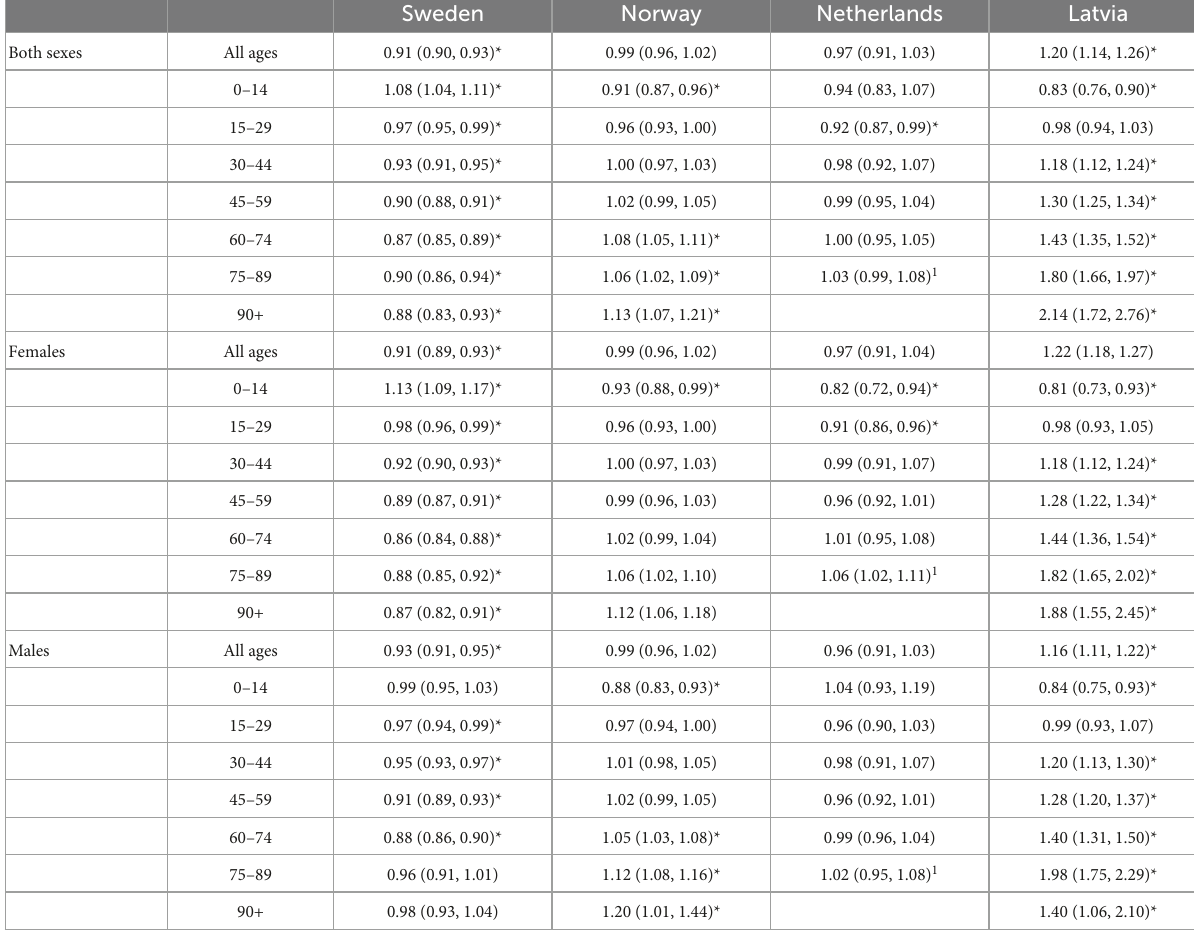
TABLE 2 Prevalence ratios (observed divided by expected) of common mental disorders (CMD) during the pandemic (Mars 2020-December 2020) in Sweden, Norway, Netherlands, and Latvia during the first year of the COVID-19 pandemic (March 2020-December 2020). Sweden Norway